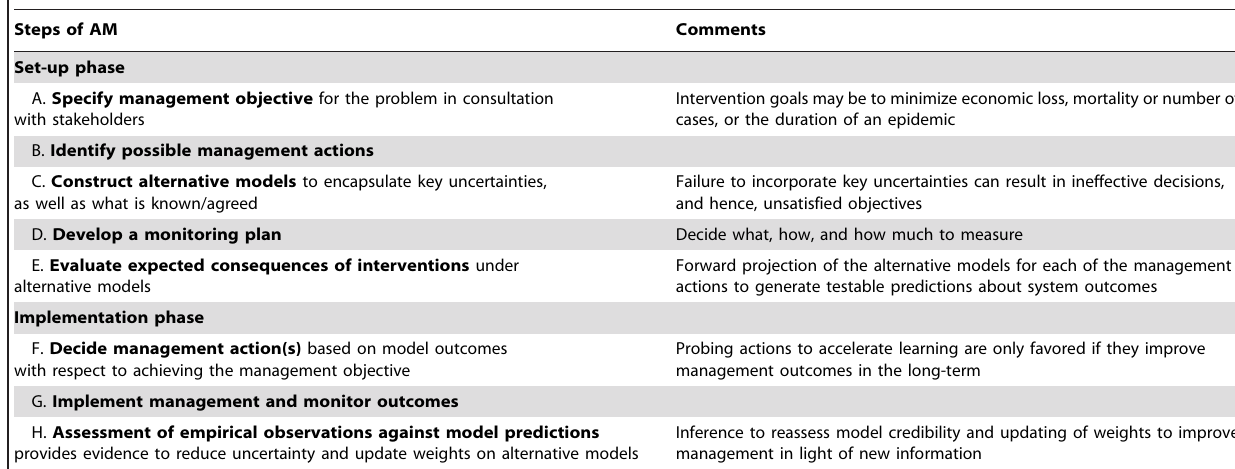
Table 1. Steps in an adaptive management framework.